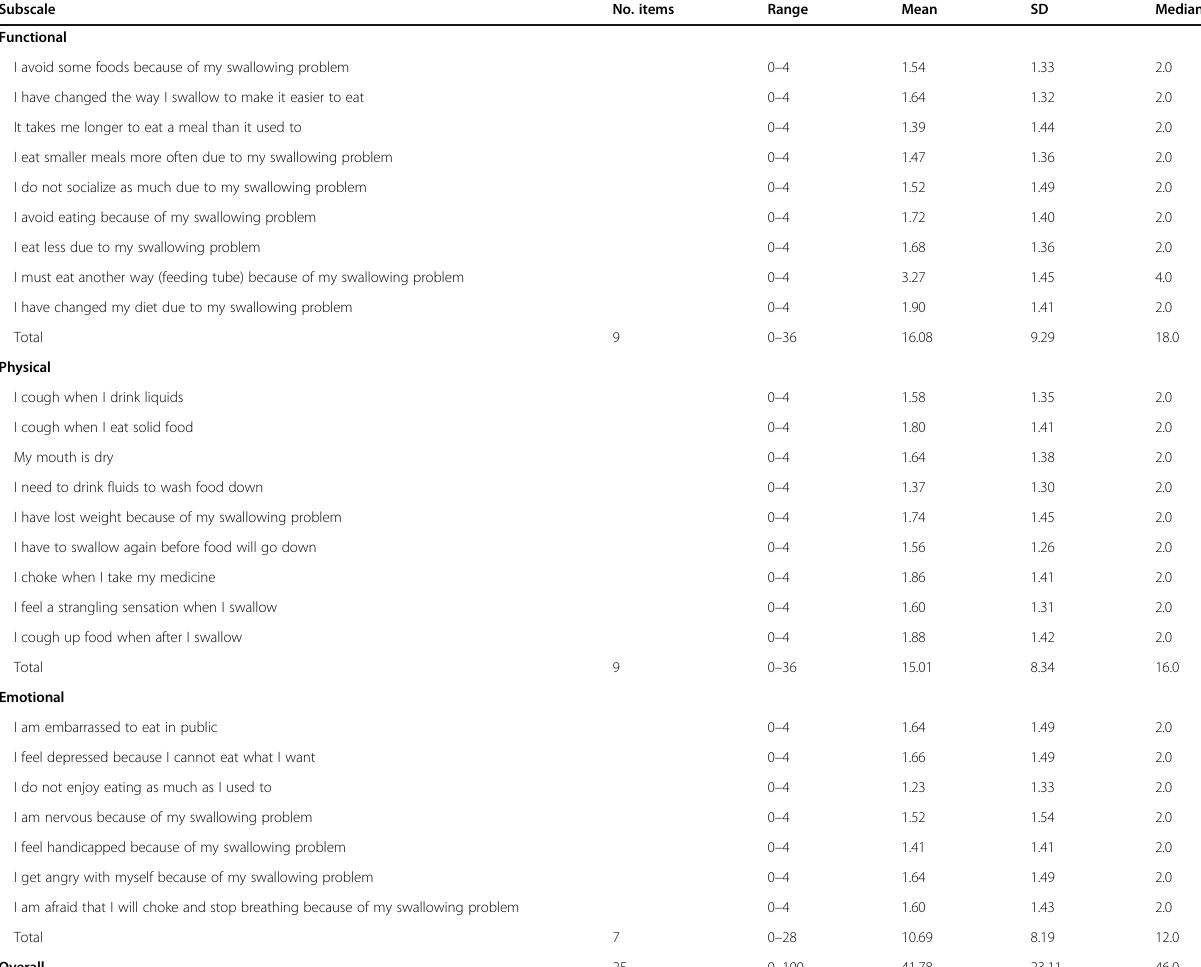
Table 5 Score distribution of Dysphagia Handicap Index